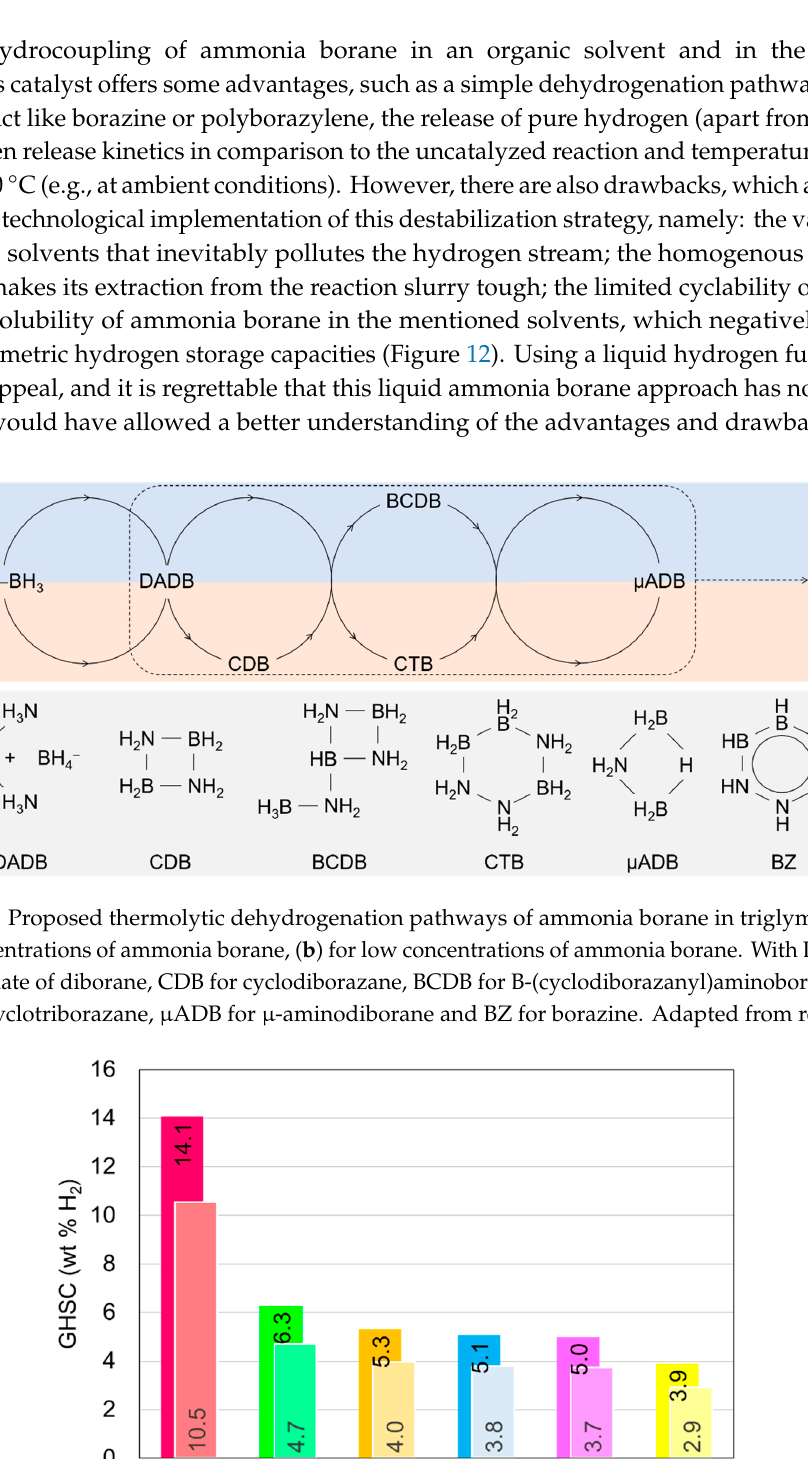
Figure 12. Gravimetric hydrogen storage capacity (GHSC) of ammonia borane in liquid ammonia, the ionic liquid 1-butyl-3-methylimidazolium chloride (BmimCl), diglyme, water, triglyme and tetrahydrofuran (THF). The solubility limit of ammonia borane in 100 g of these solvents is 259.7, 47.5, 37.4, 35.1, 34.4 and 25 g respectively. With respect to the bars with no border, the capacity is based on 100% of the hydrogens of ammonia borane. For the bars with the white borders, it is assumed that 75% of the hydrogen of ammonia borane can be released. The capacities (in wt% H 2 ) are all given.